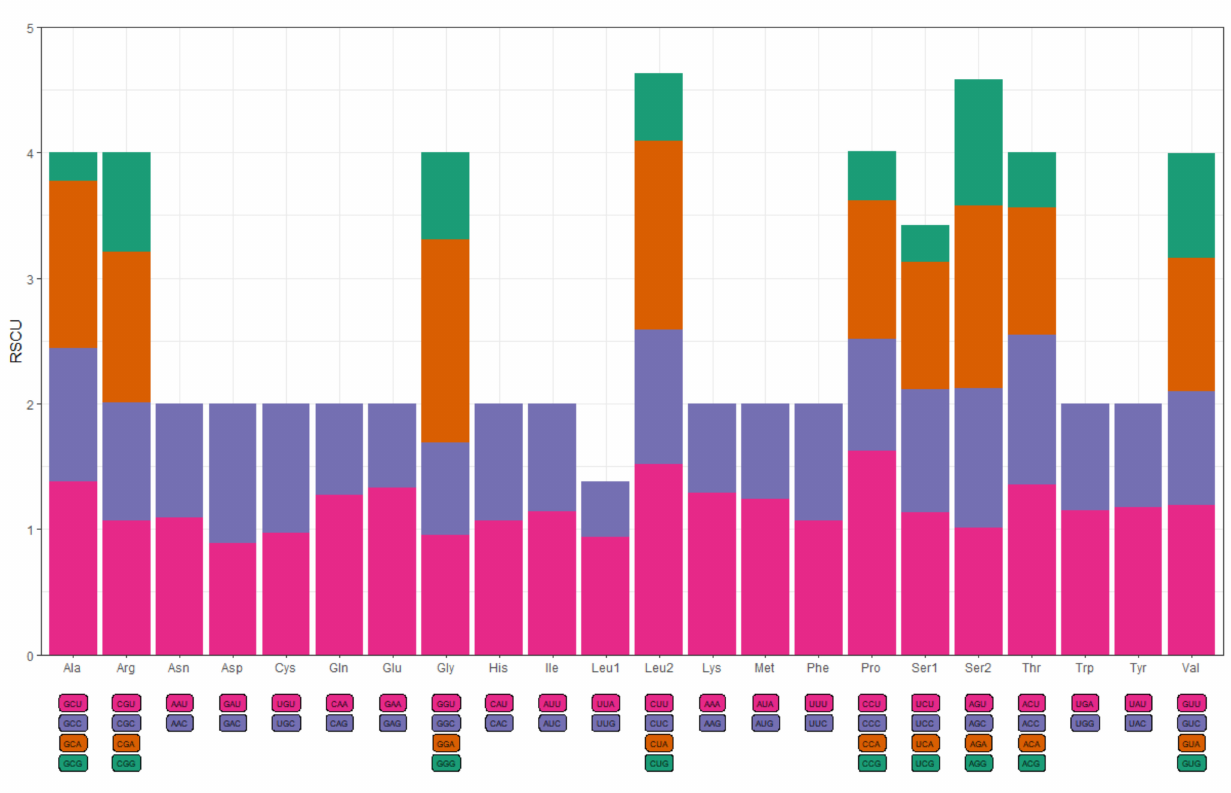
Figure 2. Relative synonymous codon usage (RSCU) in the mitogenome of B. argus . The horizontal coordinates represent the amino acids encoded by the codon, and the vertical coordinates represent RSCU